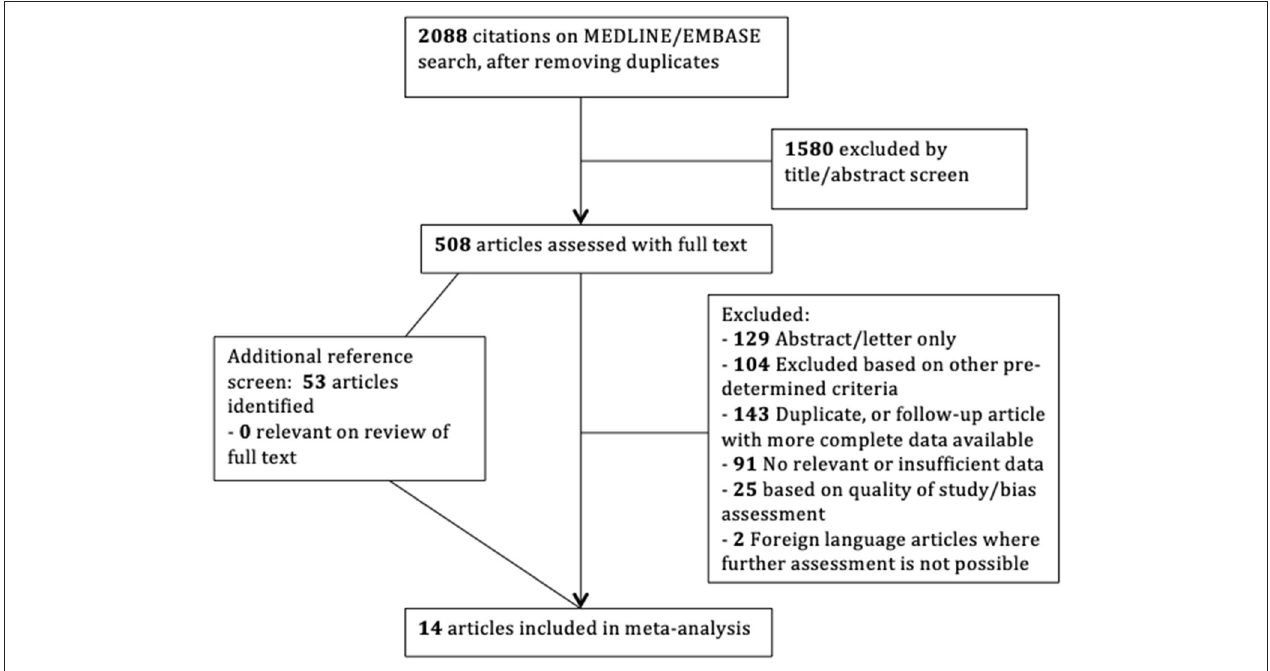
FIGURE 1 | Study selection